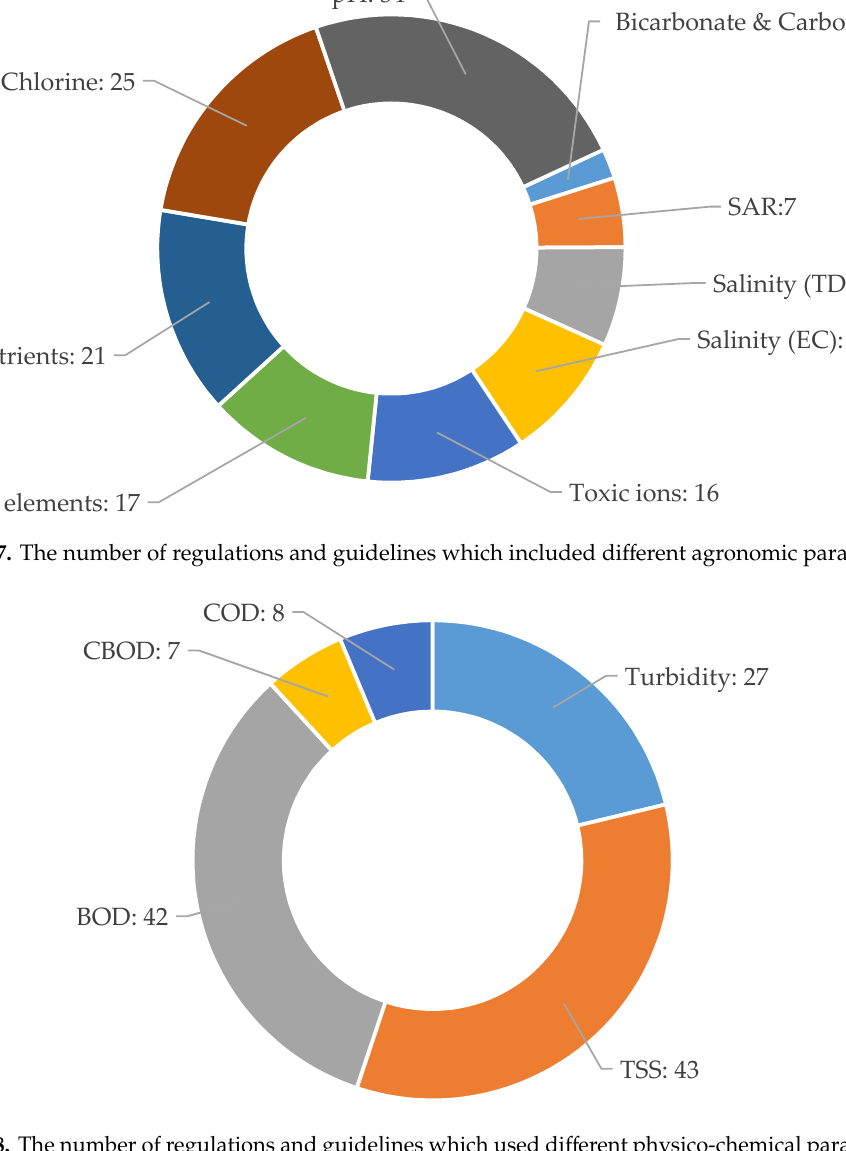
Figure 8. The number of regulations and guidelines which used di ff erent physico-chemical parameters.